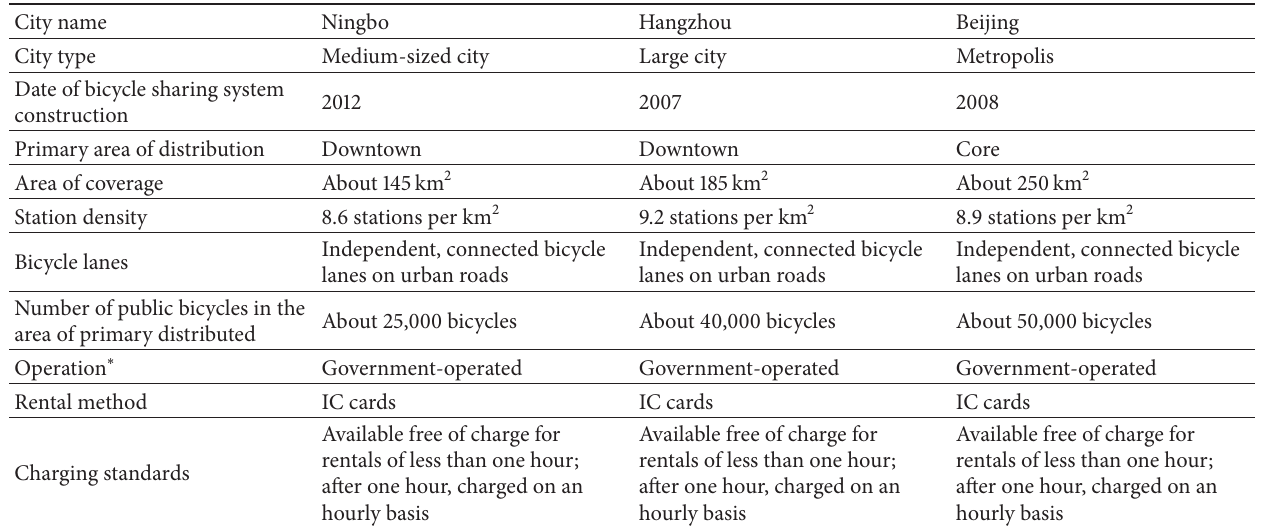
Table 1: Basic information about the three cities.